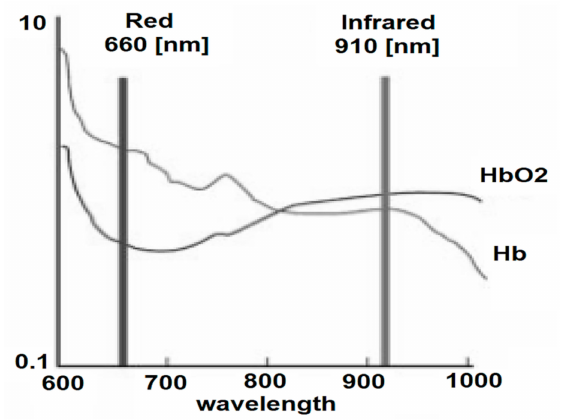
Figure 7. Light absorption by the two forms of